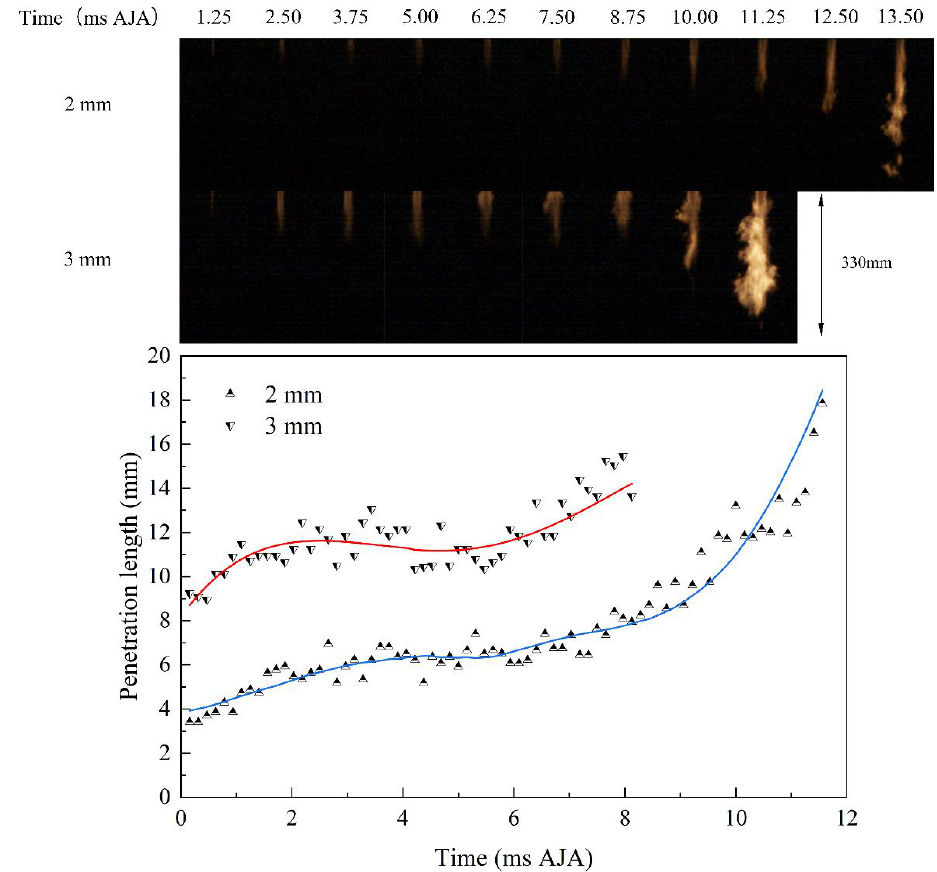
Figure 16. Natural luminescence images and penetration lengths of the jet from different orifice diameter pre-chambers.